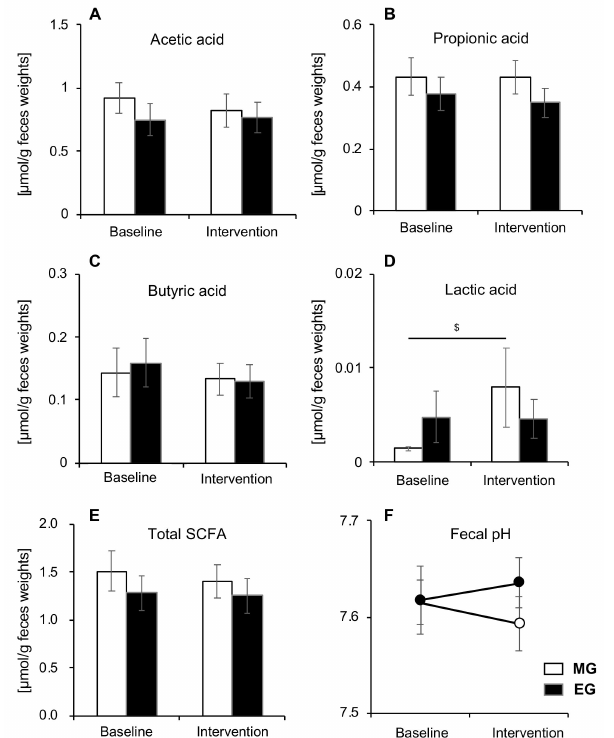
Figure 5. Changes in SCFA and pH before and after intervention in both groups ( n =